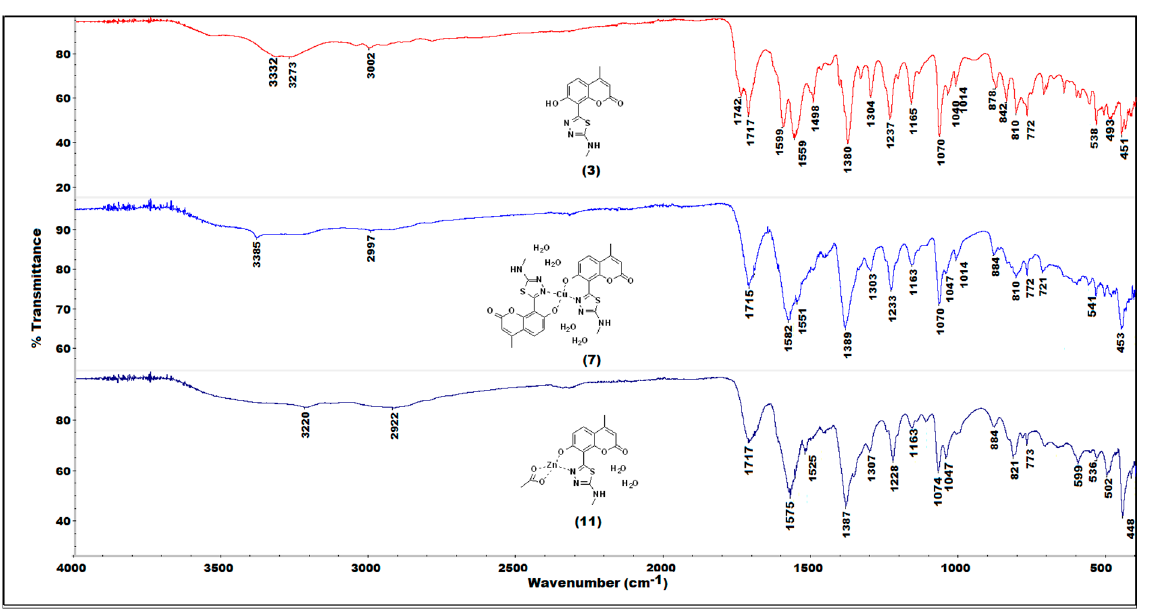
Figure 5. Comparison of IR (ATR) spectra of the coumarin-thiadiazole hybrid 3 and its corresponding Cu(II) and Zn(II) complexes ( 7 and 11 , respectively).